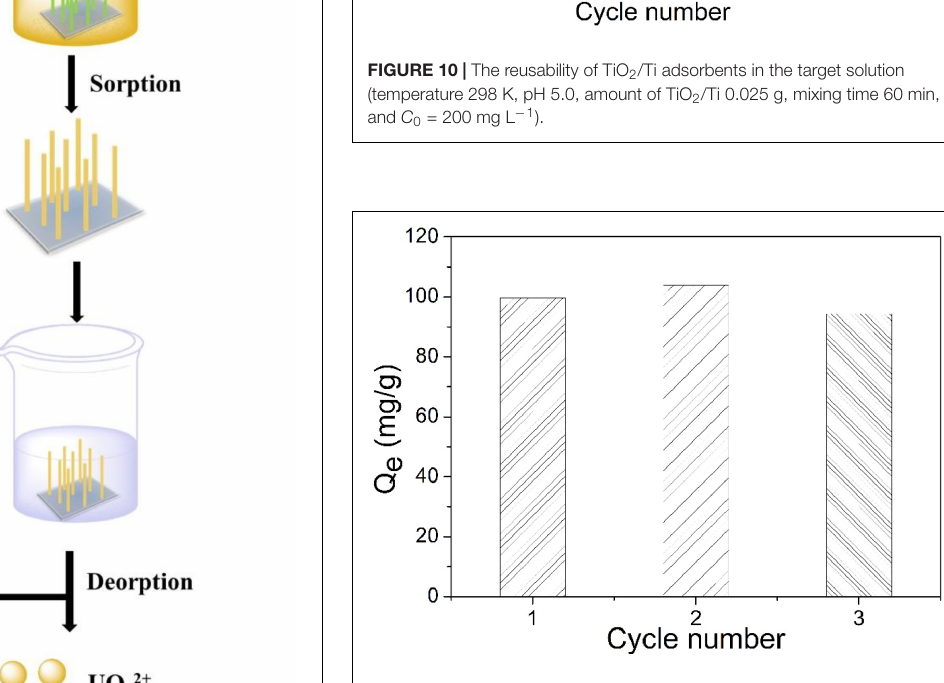
FIGURE 11 | The reusability of TiO 2 /Ti adsorbents evaluated in three identical uranium solutions (temperature 303 K, pH 5.0, amount of TiO 2 /Ti 0.025 g, mixing time 60 min, and C 0 = 100 mg L − 1